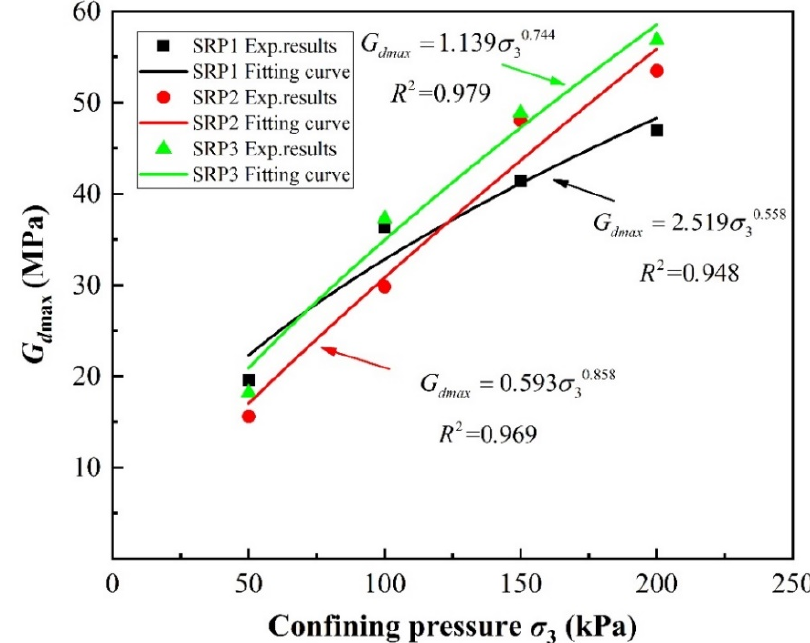
Figure 17. Effect of confining pressure on maximum dynamic shear moduli ( G dmax ) of sand–rubber mixtures with 20% rubber volume content.